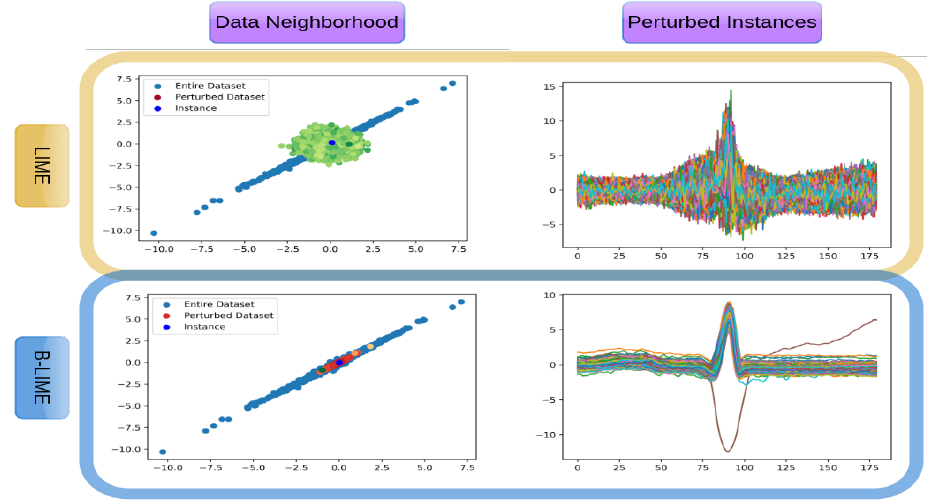
Figure 3. Data Generation